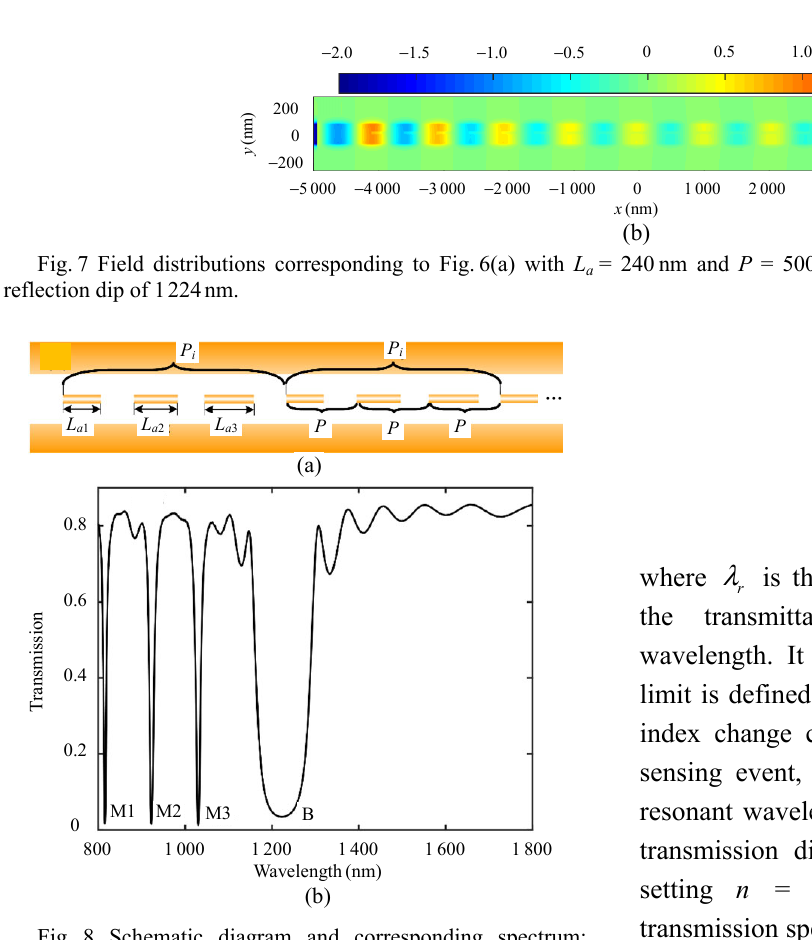
Fig. 8 Schematic diagram and corresponding spectrum: (a) schematic diagram of three gratings integrated in a large period and (b) transmission